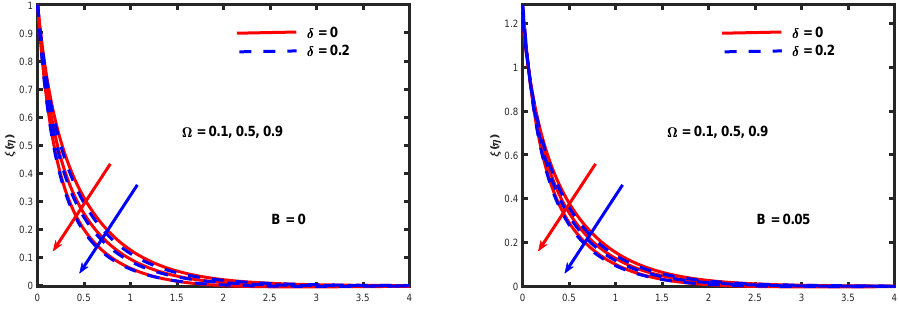
Figure 17. Influence of unsteady parameter and microorganism concentration difference on ξ .